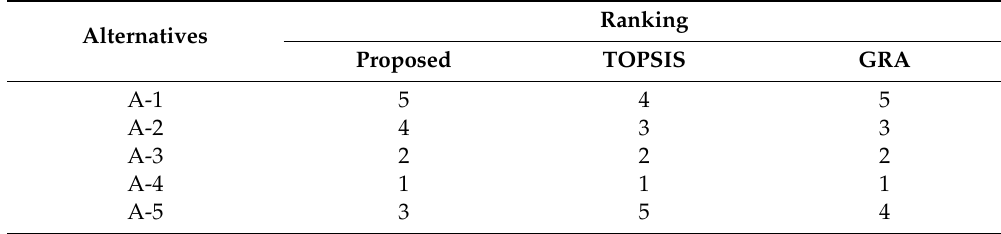
Table 7. Comparison of proposed methodology with TOPSIS and GRA.